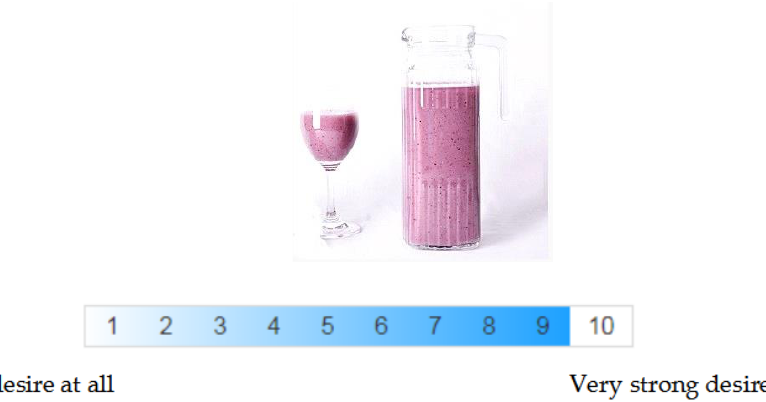
Figure A4. The picture of purple potato products (Liquid food).